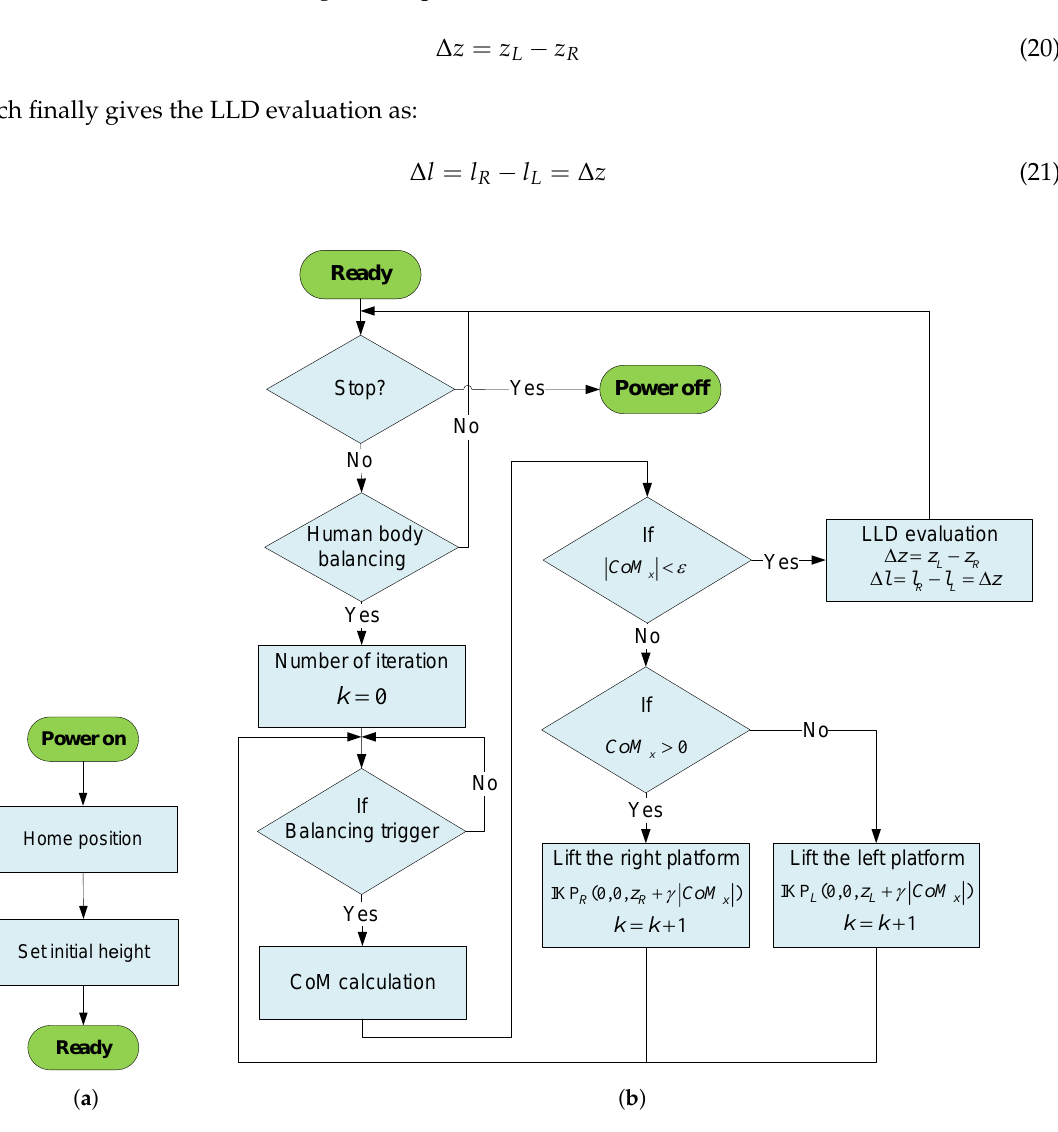
Figure 8. Flowchart: ( a ) Turning the system on and moving the 3-RPS parallel manipulators to their initial height; and ( b ) Human Body Balancing